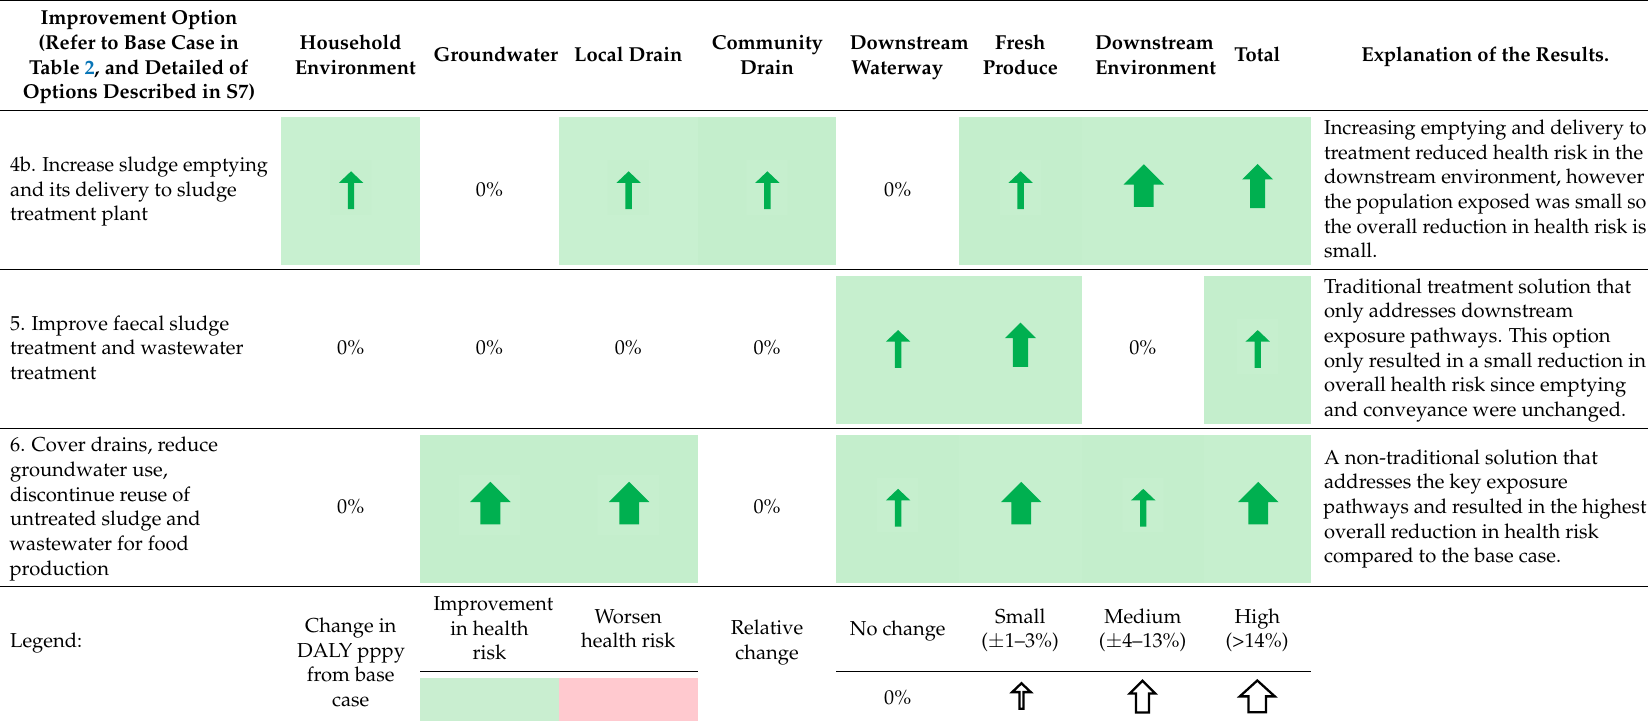
Table 3. Change in DALY per person per day from base case (based on exposure frequency and proportion of population exposed for Adults).